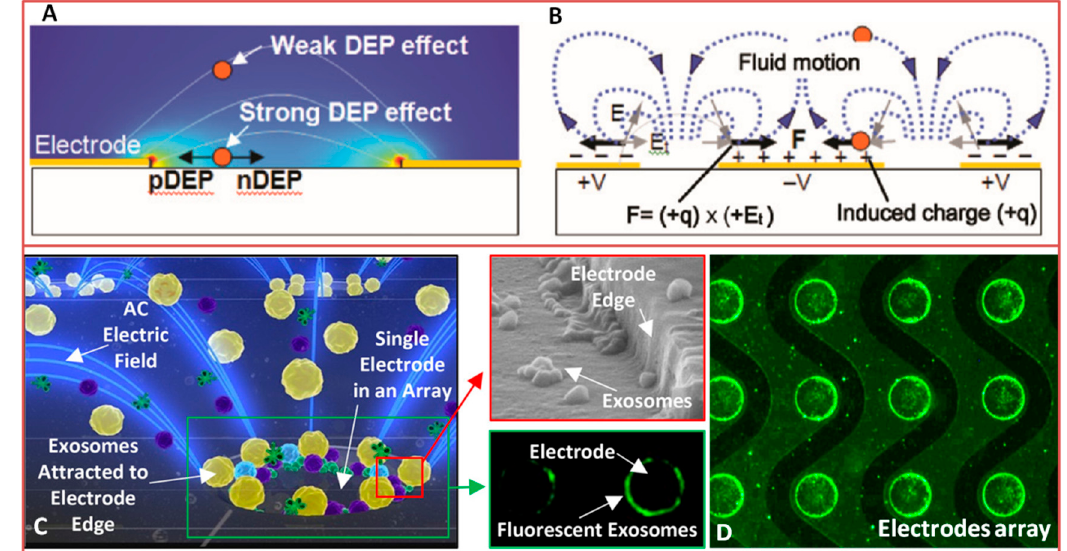
Figure 6. Schemes of two of the main electrokinetic behaviours ( A ) Dielectrophoresis; ( B ) Electro-osmosis. Figure reproduced with permission from reference [155]; ( C ) AC separation of exosomes through an array of circular electrodes confirmed by SEM and fluorescent acquisitions ( D ) Reproduced with permission from [165].